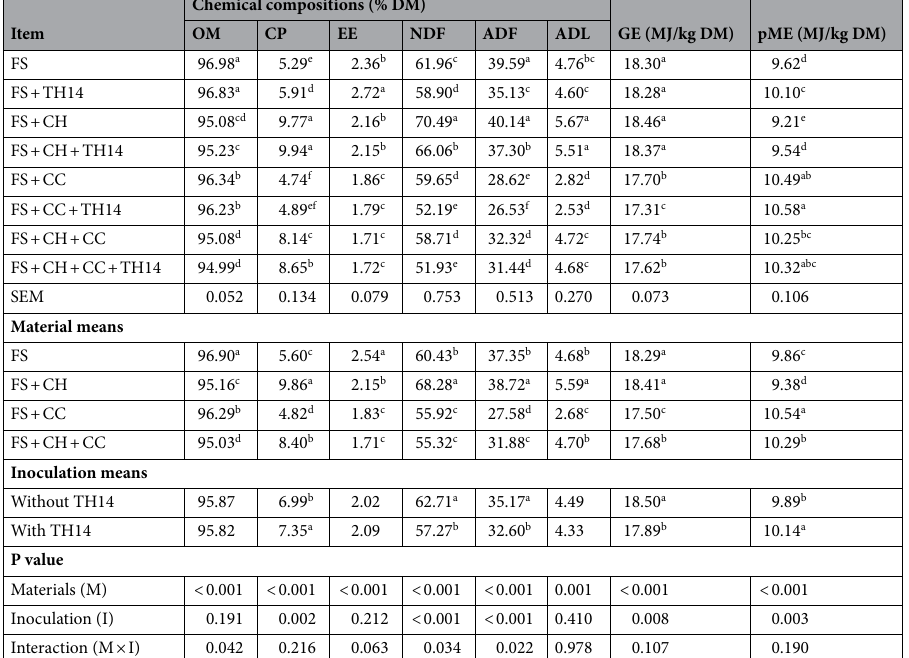
Table 4. Chemical compositions and energy contents of the FS mixture silages. FS forage sorghum, CH Cavalcade hay, CC cassava chip, TH14 L. casei TH14 inoculant, SEM standard error of the means, DM dry matter, OM organic matter, CP crude protein, EE ether extract, NDF neutral detergent fiber, ADF acid detergent fiber, ADL acid detergent fiber, GE gross energy, pME predicted metabolizable energy. Means within columns with difference superscript letters differ at p < 0.05.